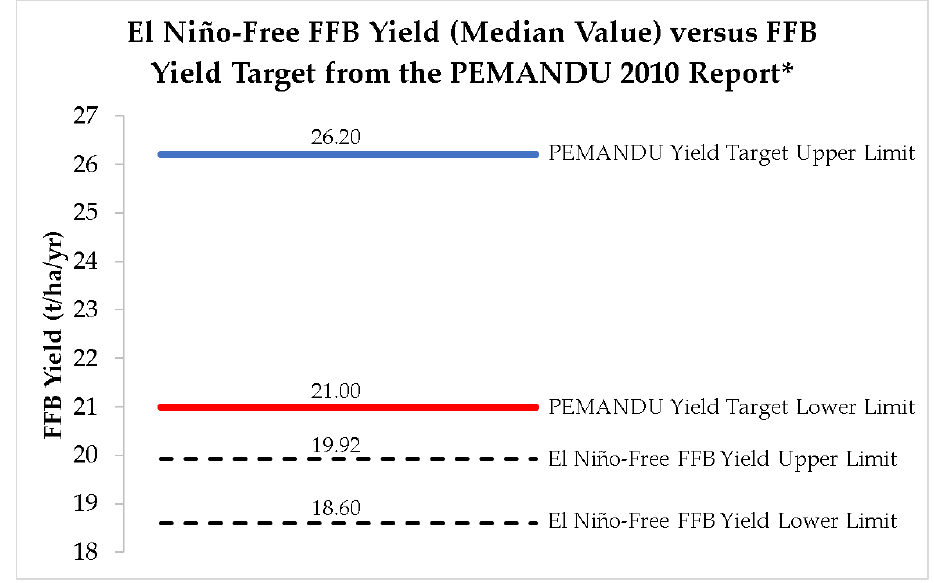
Figure 12. Comparison of PEMANDU FFB yield target and the El Niño–free yield data study (bootstrapped BCa 99% confidence intervals) in Malaysia. * PEMANDU 2010 ETP report can be found in [10].